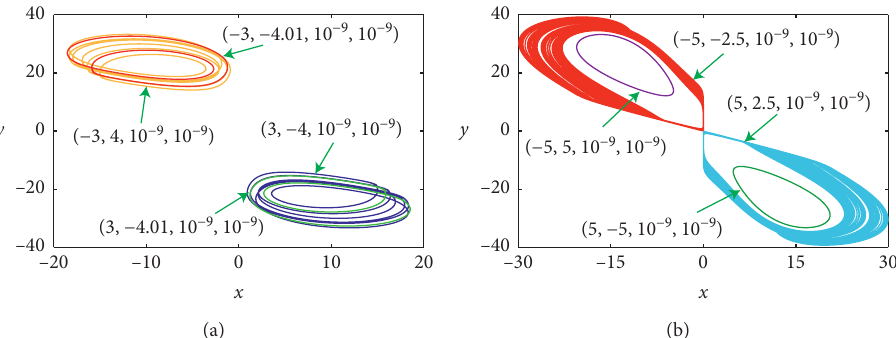
Figure 8: Numerically simulated phase plane plots in the x – y plane for different d , f and initial conditions. (a) Coexistence of limit cycles with period-2 and period-6 under the initial conditions ( ± 3, ∓ 4.01, 10 − 9 , 10 − 9 ) and ( ± 3, ∓ 4, 10 − 9 , 10 − 9 ), respectively for d � 0.3593 and f � 1.88. (b) Coexistence of limit cycles with period-1 and single-scroll chaotic attractors under the initial conditions ( ± 5, ∓ 5, 10 − 9 , 10 − 9 ) and ( ± 5, ∓ 2.5, 10 − 9 , 10 − 9 ), respectively, for d � 0.5 and f � 0.2155.